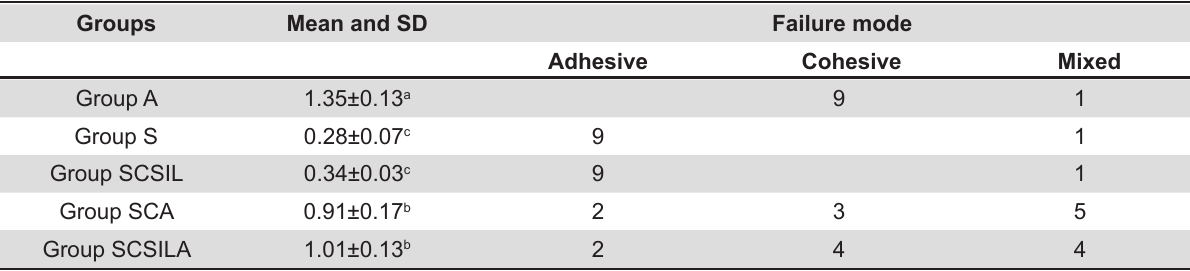
Table 1- The Group bond strength values (MPa) and failure mode